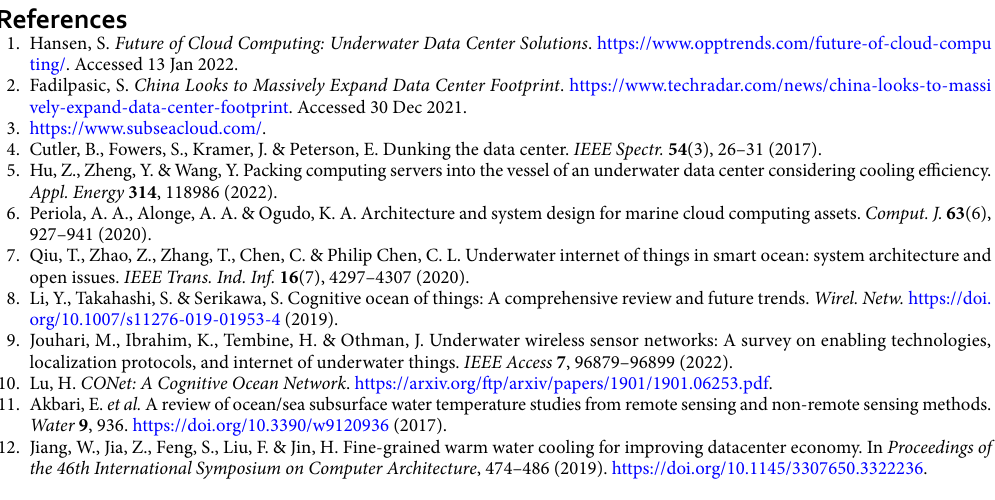
Figure 10. ( a ) Simulated results for the operational Duration given 3 Phases for a case of 15 epochs. ( b ) Simulated results for the operational Duration given 4 Phases for a case of 15 epochs. ( c ) Simulated results for operational Duration given 5 Phases for a case of 15 epochs. ( d ) Simulated results for operational Duration given 6 Phases for a case of 15 epochs. Evaluation showing results for the underwater data center duration (for 3 phases, 4 phases, 5 phases and 6 phases) in the case that the marine heat wave event occurs for 15